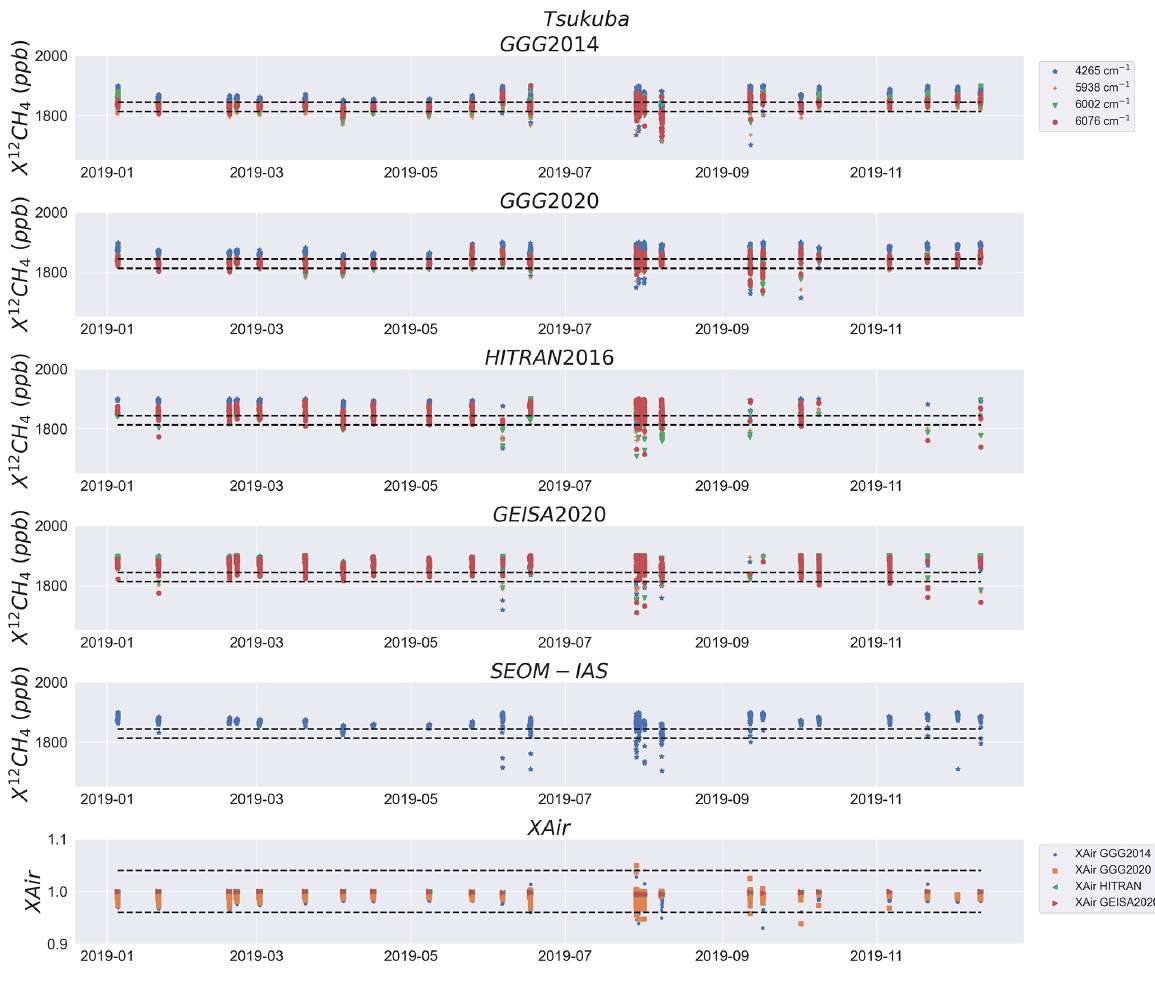
Figure 6. As Fig. 4 but for retrievals from the Tsukuba